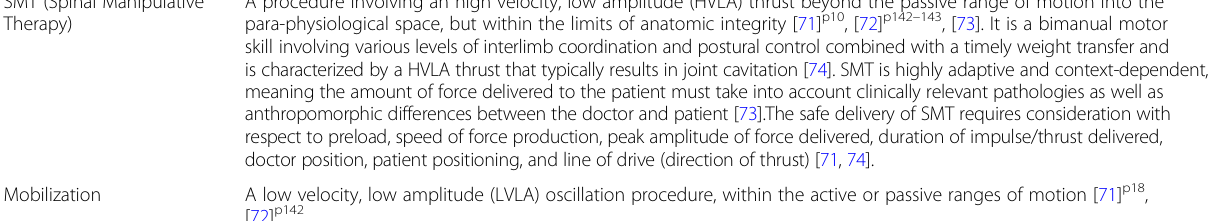
Table 2 Abbreviations and definitions used for this study SMT (Spinal Manipulative